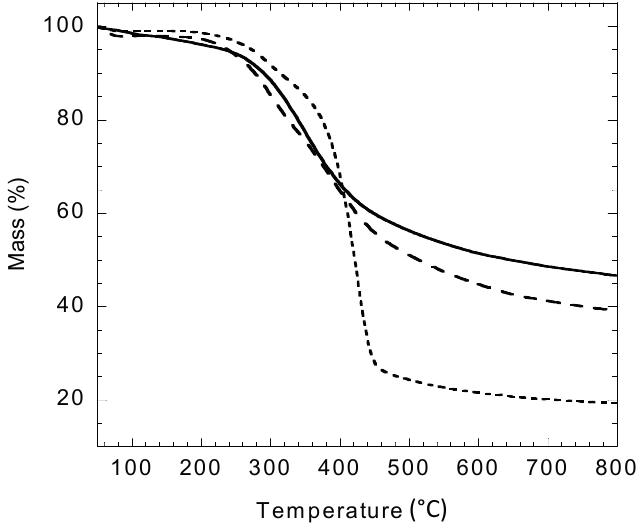
Figure 7. TGA analysis of original Kraft lignin (continuous line), control Kraft lignin extracted from the [C 4 C 1 mim][OTf]/[C 4 C 1 mim][PF 6 ] binary system without enzyme (large dotted line) and lignin oleate extracted from [C 4 C 1 mim][OTf]/[C 4 C 1 mim][PF 6 ] binary system after transesterification catalyzed by the immobilized lipase B from Candida antarctica (small dotted